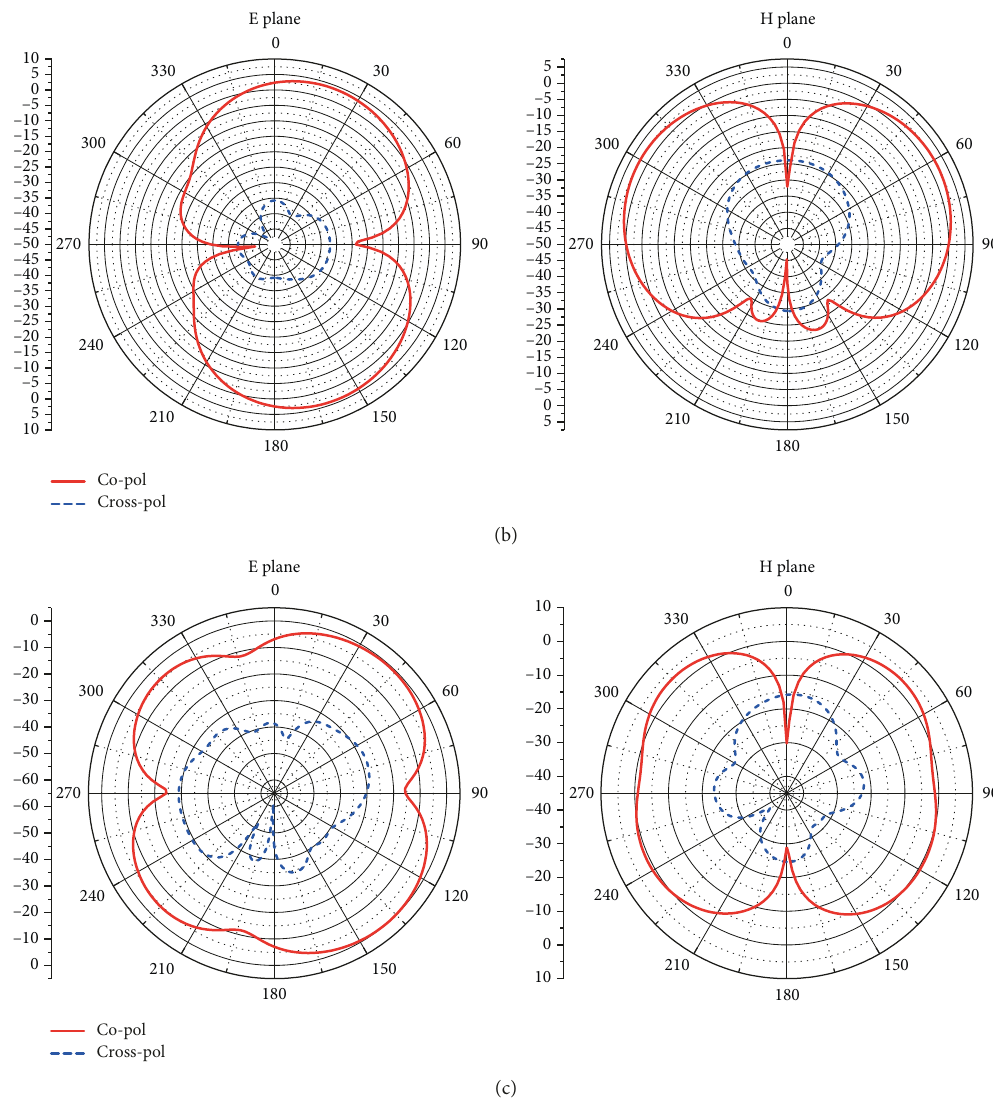
Figure 7: E- and H-plane radiation patterns. (a) 2GHz. (b) 3.25GHz. (c)